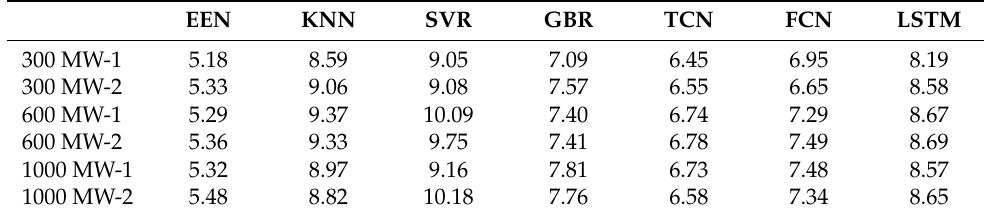
Table 3. MAPE of hourly CO 2